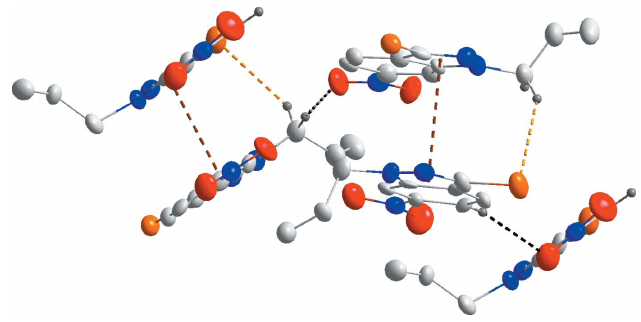
Figure 2 Detail of the intermolecular interactions. C—H (cid:4)(cid:4)(cid:4) O and C—H (cid:4)(cid:4)(cid:4) Br hydrogen bonds and the (cid:2) -stacking interactions are shown, respectively, as black, light-orange and brown dashed lines.